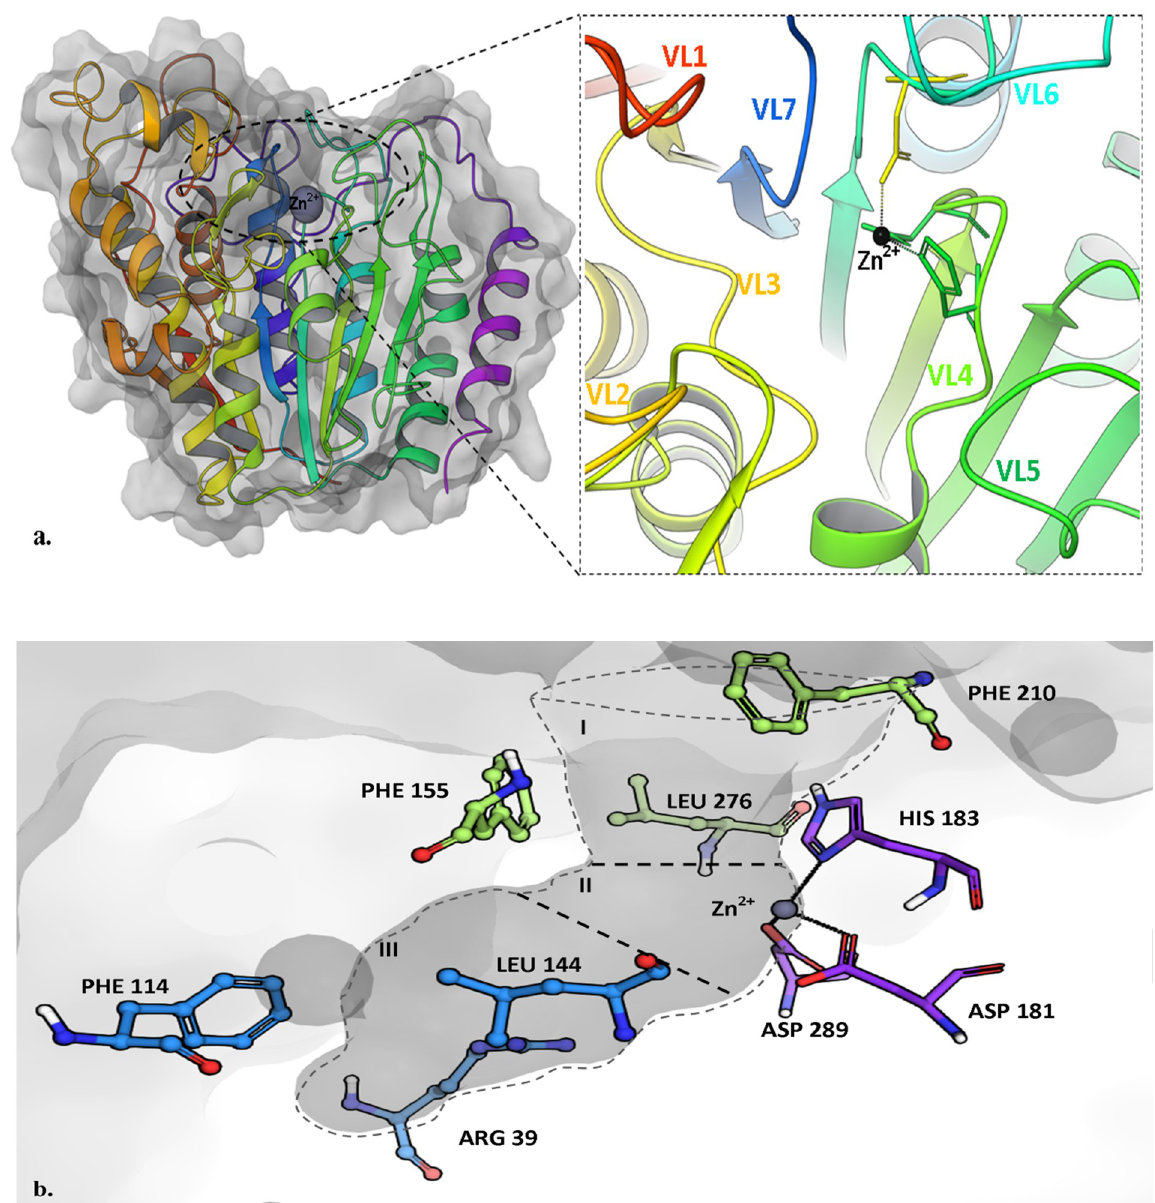
Fig 2. Structure of HDAC2. (A) Cartoon representation of HDAC2 highlighting the variable loop region making the orifice of the binding cleft. (B) HDAC2 binding site featuring the active site residues in 3 regions; (I) hydrophobic pit, (II) metal-coordinated catalytic pocket, and (III) foot